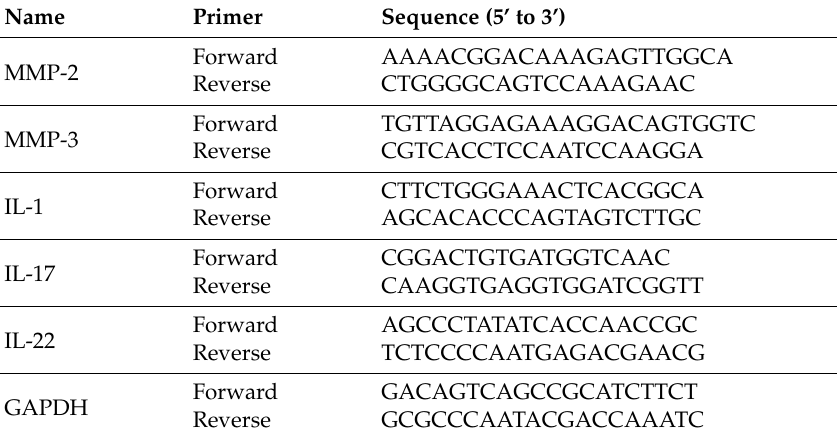
Table 2. Sequences of primers (human) used in quantitative real-time